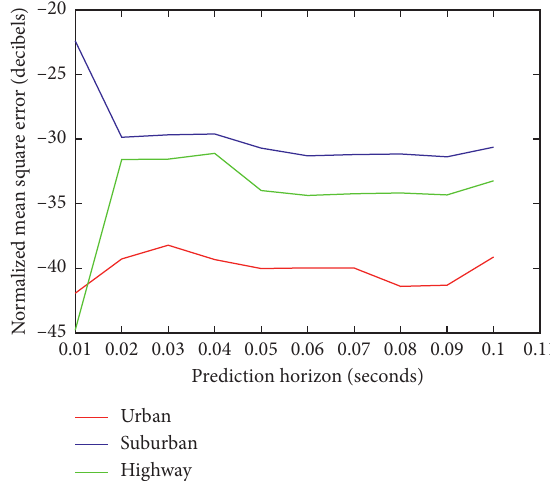
Figure 9: NMSE vs. prediction horizon for different urban, sub- urban, and highway environments with k � 16, L � 100, and Δ t � 1ms.